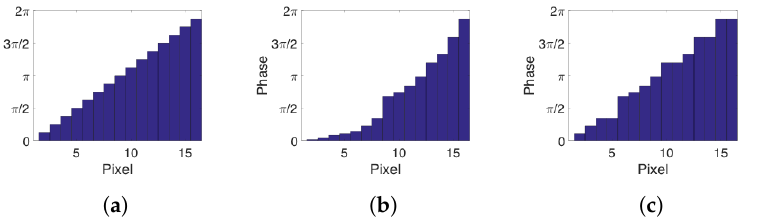
Figure 1. Phase profiles for one period of: ( a ) A linear distribution of phase levels, ( b ) nonlinear (all 16 available phase levels on the device), and ( c ) a forced linear distribution of phase levels mapped to the available states of the device when illuminated with a 532 nm